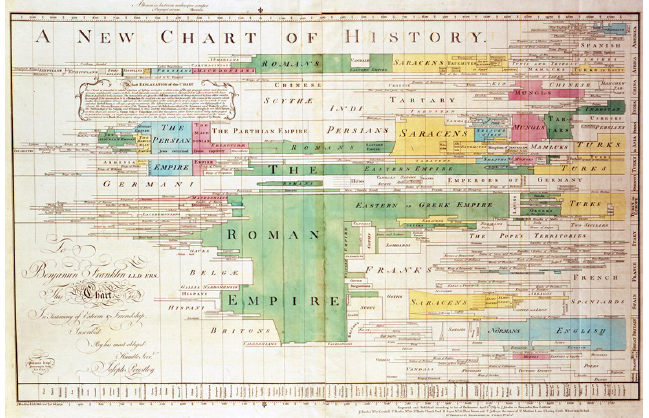
Fig. 2 Joseph Priestley, A New Chart of History ,